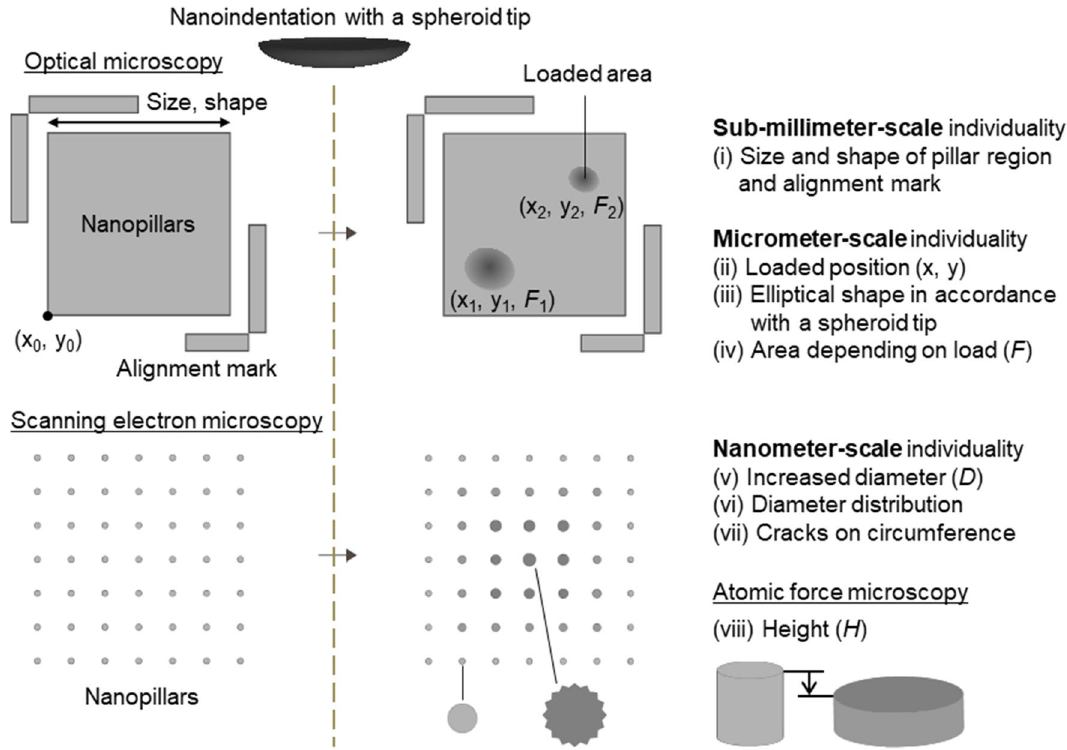
Figure 1. Multi-scale (sub-millimetre, micrometre, and nanometre) and multi-level (shape, area, diameter, and height) individuality authentication and clone resistance of long-term reliable synthetic quartz (SQ) nanopillars after plastic deformation by